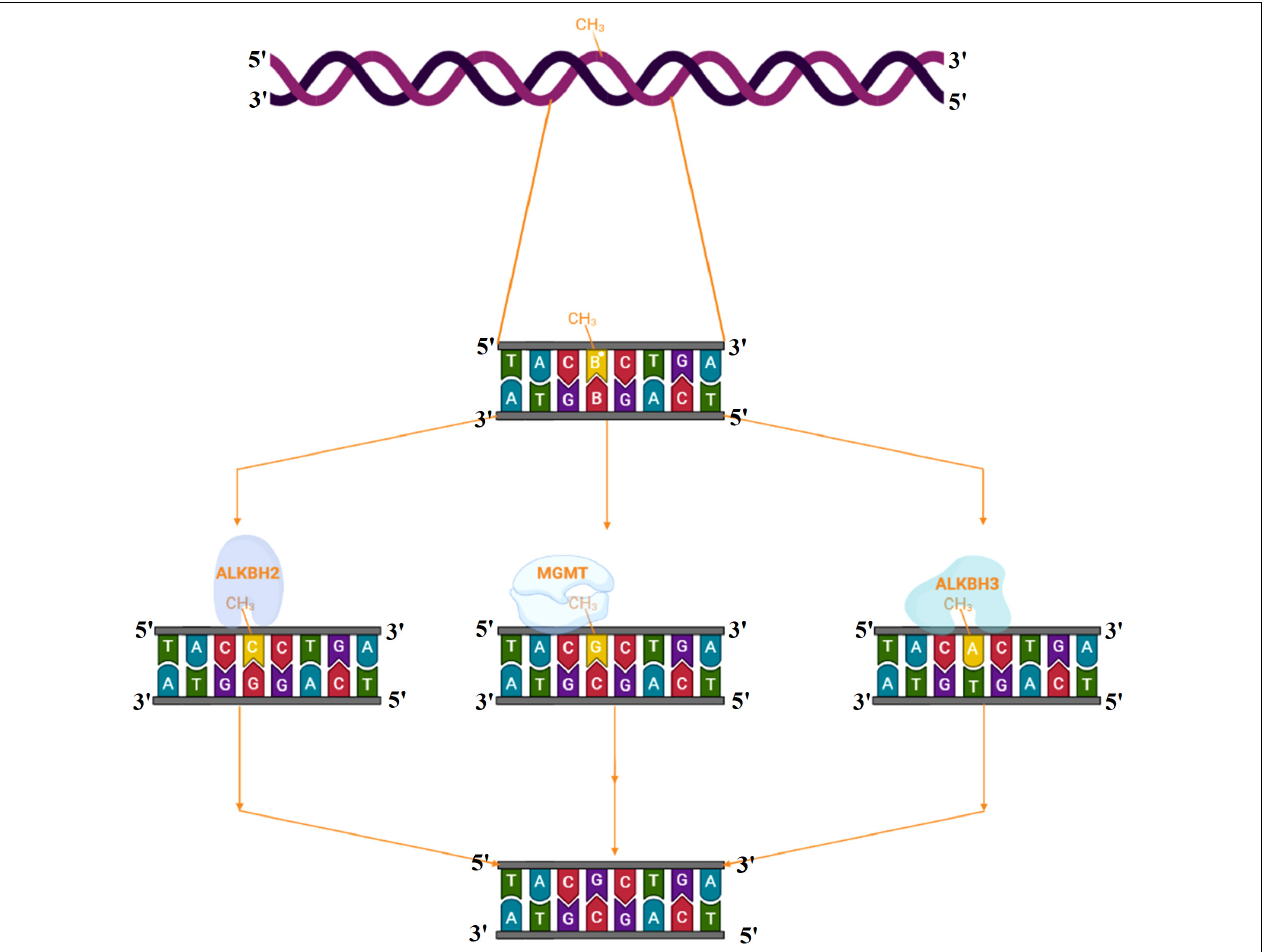
FIGURE 2 | Direct reversal of N alkylated DNA bases by alkyltransferase and